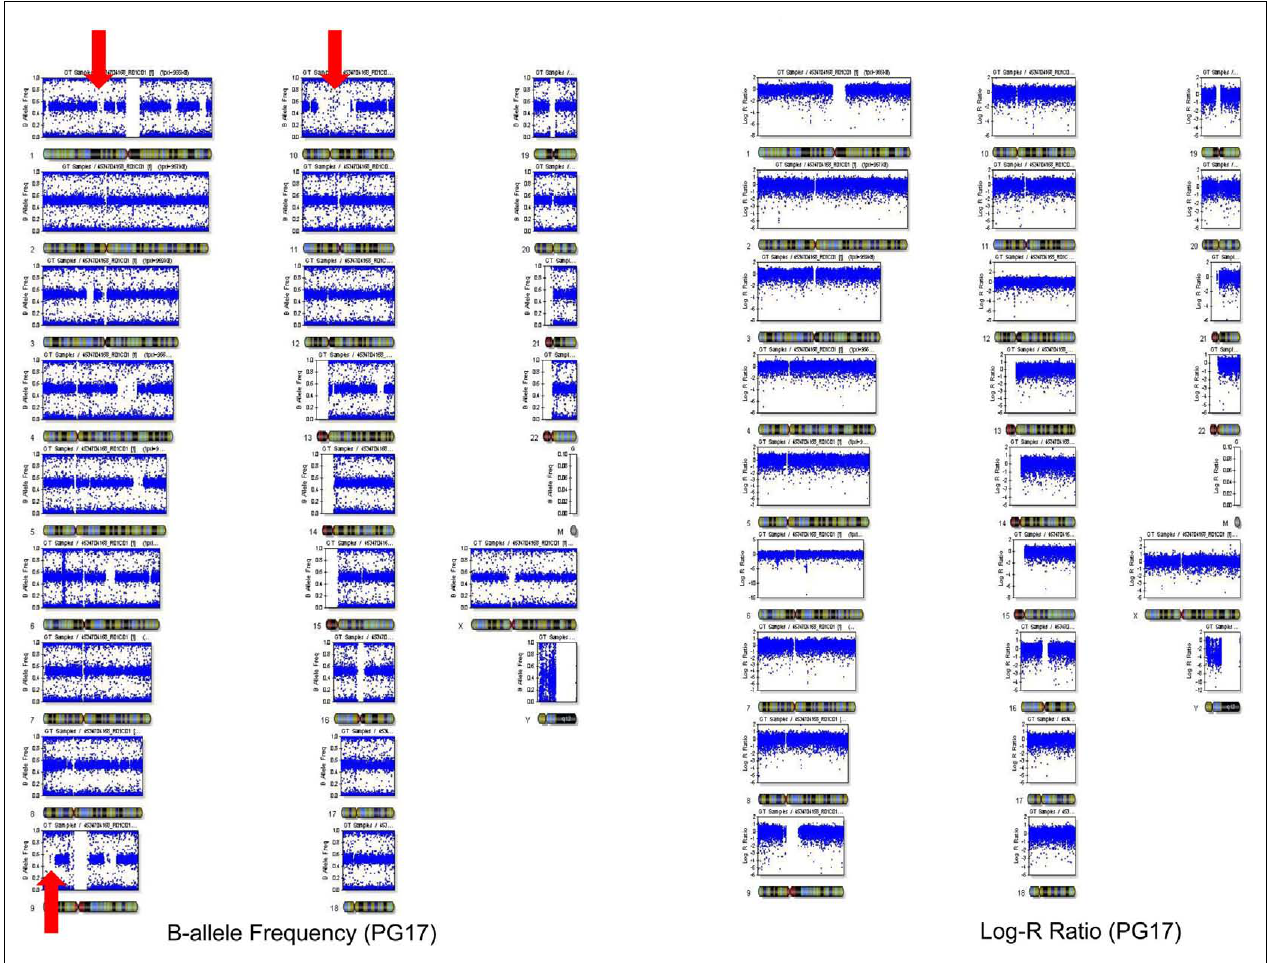
stretches of homozygosity across many chromosomes (see red arrows). However, this was not associated with a shift in log R ratio at these locations suggesting that this was not due to big deletions but probably to inbreeding of her ancestors with distant relatives that resulted in higher homozygosity.